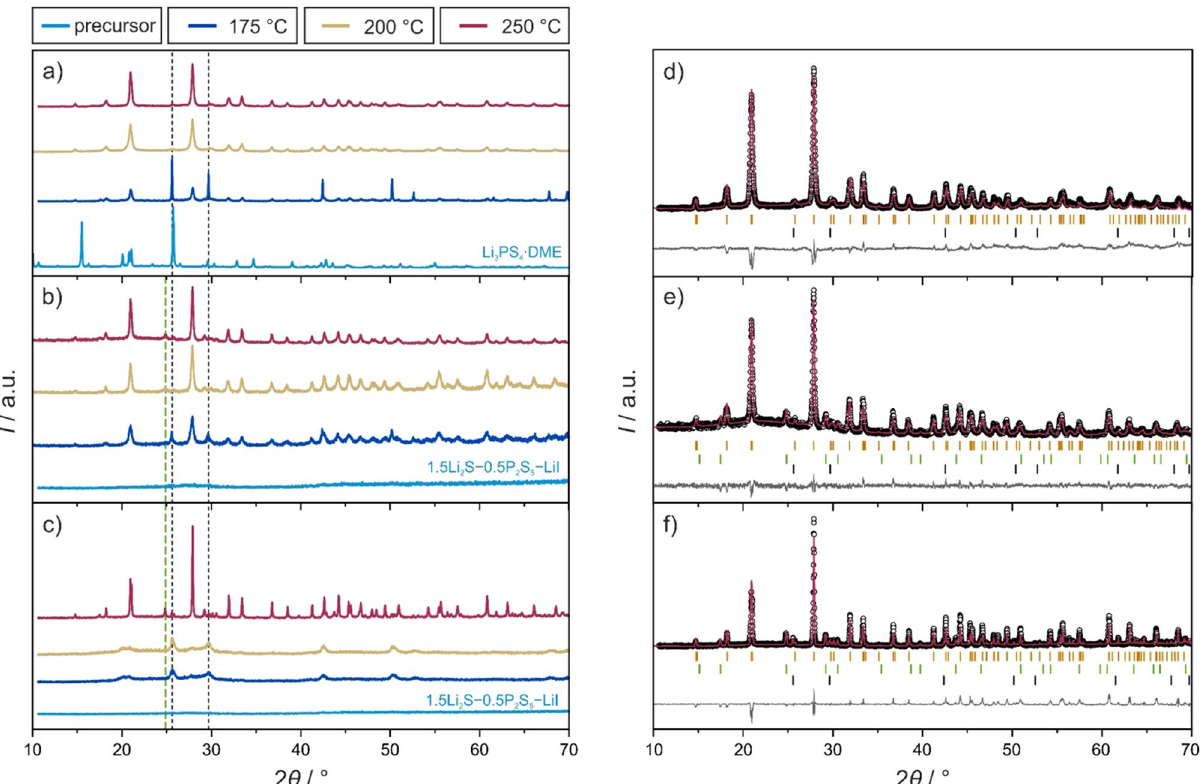
Figure 2. XRD patterns of Li 4 PS 4 I prepared by ( a ) wet-chemical, ( b ) solid-state or ( c ) hot-press synthesis at different temperatures of 175, 200 and 250 °C. Patterns of the corresponding precursors are also shown. Note that for the wet-chemical synthesis, only the Li 3 PS 4 ∙DME precursor is shown for clarity, and 1.5Li 2 S–0.5P 2 S 5 –LiI represents the amorphous Li 4 PS 4 I phase produced by ball milling. Green and black dashed lines indicate the main reflections of argyrodite Li 6 PS 5 I and LiI, respectively. Rietveld refinement plots for the samples prepared at 250 °C by ( d ) wet-chemical, ( e ) solid-state or ( f ) hot-press synthesis. Experimental, calculated and difference profiles are shown as black circles and red and gray lines, respectively. Orange, black and green tick marks denote the Bragg reflections of Li 4 PS 4 I ( P 4/ nmm ), LiI ( Fm − 3 m ) and Li 6 PS 5 I ( F − 43 m ), respectively. Reliability factors are provided in Table